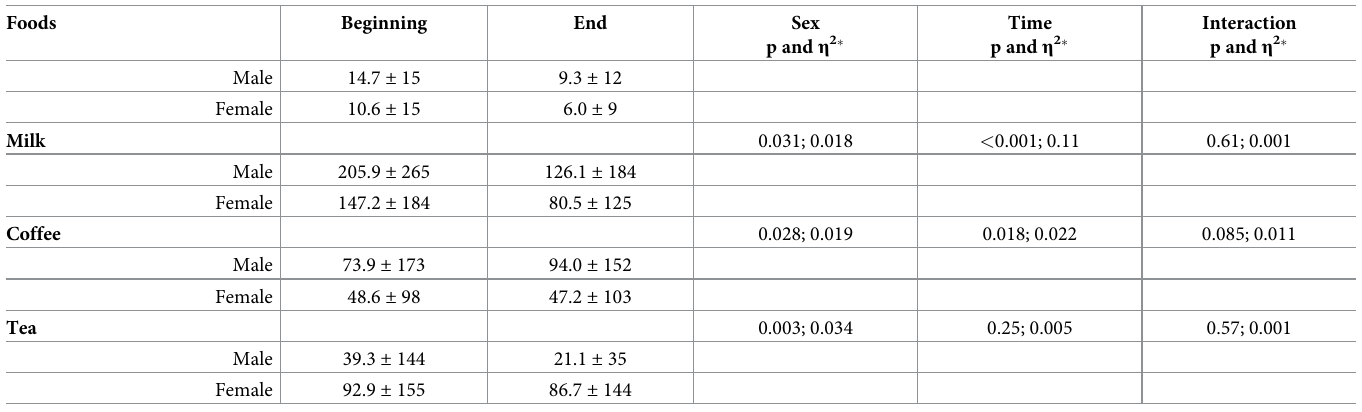
gain = 2.8 ± 2.5 kg), change in waist circumference was negatively correlated with carrot intake (R = -0.28) and positively correlated with alcohol intake as mg of ethanol (R = 0.16) and a composite term for all alcoholic beverages (beer, wine and liquor combined; R = 0.18). Apple (R = -0.15), carrot (R = -0.27) and liquor intake (R = 0.16) were significantly correlated with waist circumference in all females (n = 210) but not males. In terms of fat mass or %body fat, oranges (R = -0.17), broccoli (R = -0.14), tomatoes (R = -0.14), corn (R = -0.15) and energy drinks (R = 0.14) were significantly correlated in all females but not males; whereas temperate fruit (R = -0.28), yogurt (R = -0.38), cheese (R = -0.31) and fried chicken (R = 0.45) were signif- icantly correlated in all males (n = 50) but not females. In terms of correlated foods/beverages, juice intake was significantly positively correlated with total calories (all males: R = 0.33; all females: R = 0.20) and total sugars (all males: R = 0.57; all females: R = 0.52), as was soft drinks with total sugars (all males: R = 0.29; all females: R = 0.26). Beer intake was significantly posi- tively correlated with liquor intake (R = 0.34) in all males and wine intake (R = 0.23) in all